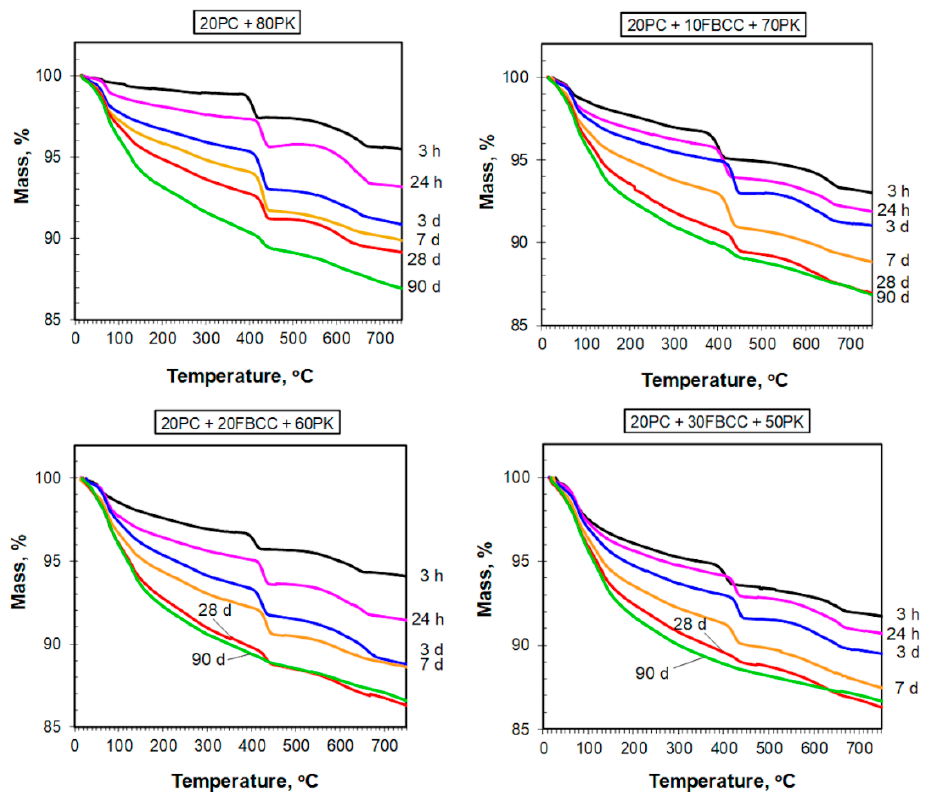
Figure 4. TG curves for blended four-component binders after different times of hydration.